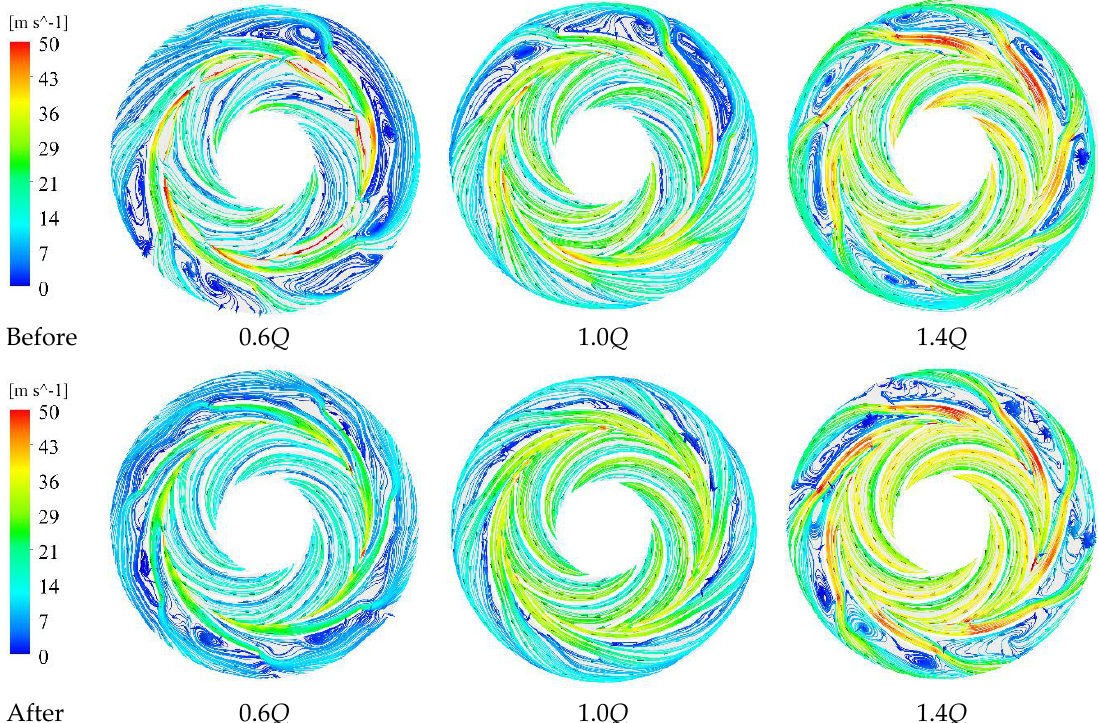
Figure 18. Streamline distribution of the first-stage impeller-guide vanes.